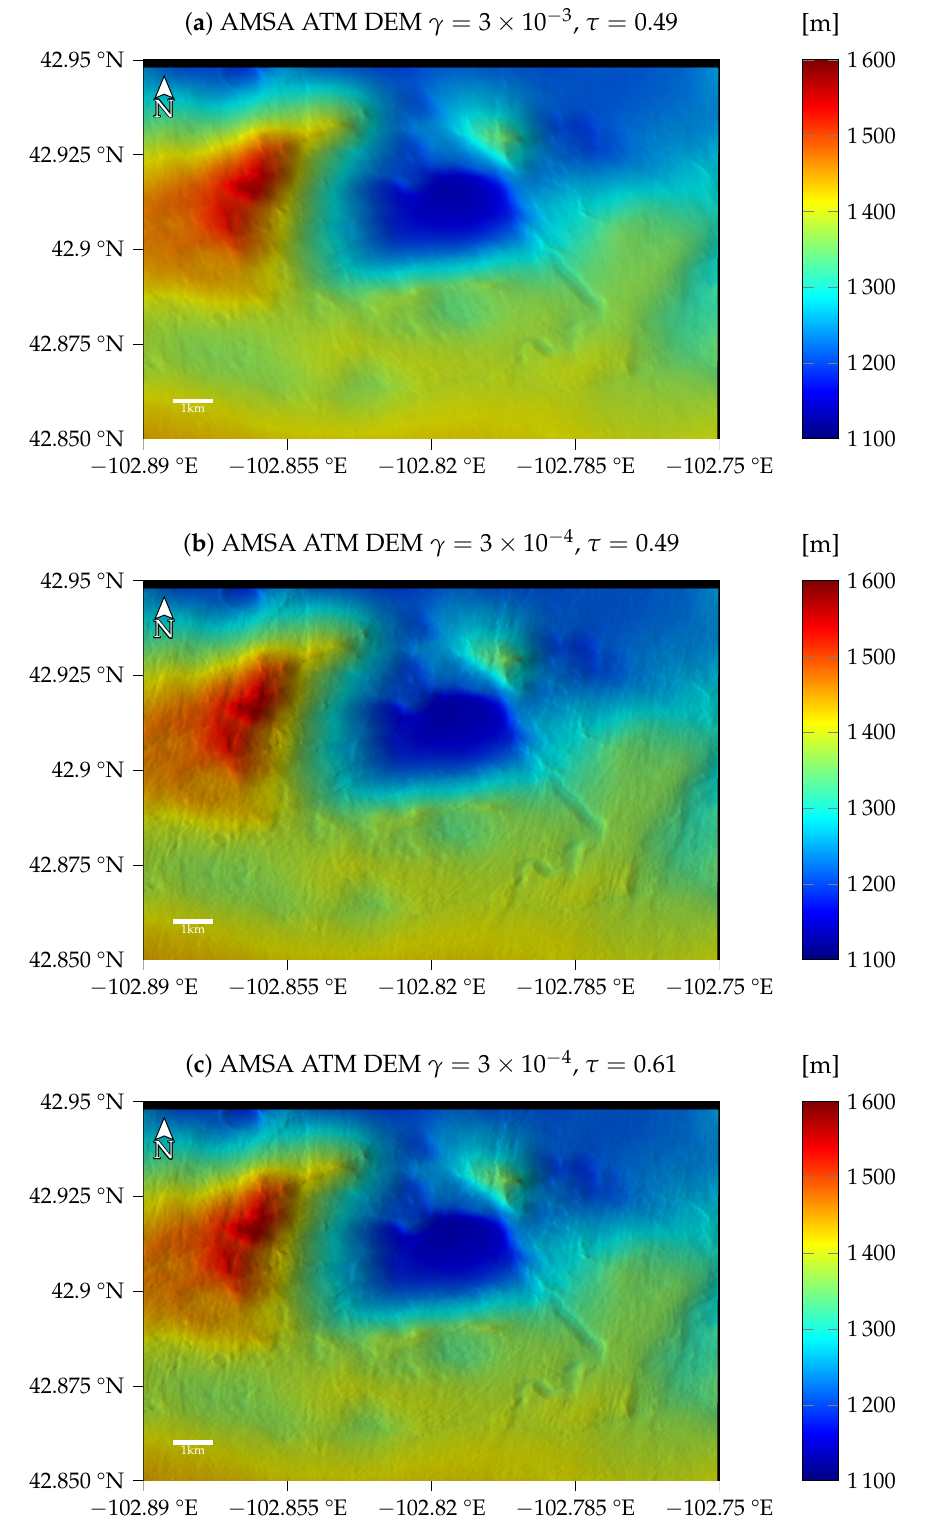
Figure A7. Color-coded and shaded DEMs created with the atmospherically compensated method not displayed in the main text of the manuscript for image K13_058554_2232_XN_43N103W (medium atmospheric